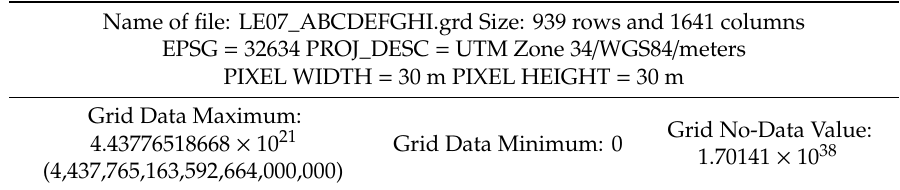
Software Surfer mathematical function). Table 1. Parameters of the resulting image of the RS algorithm application of the testing